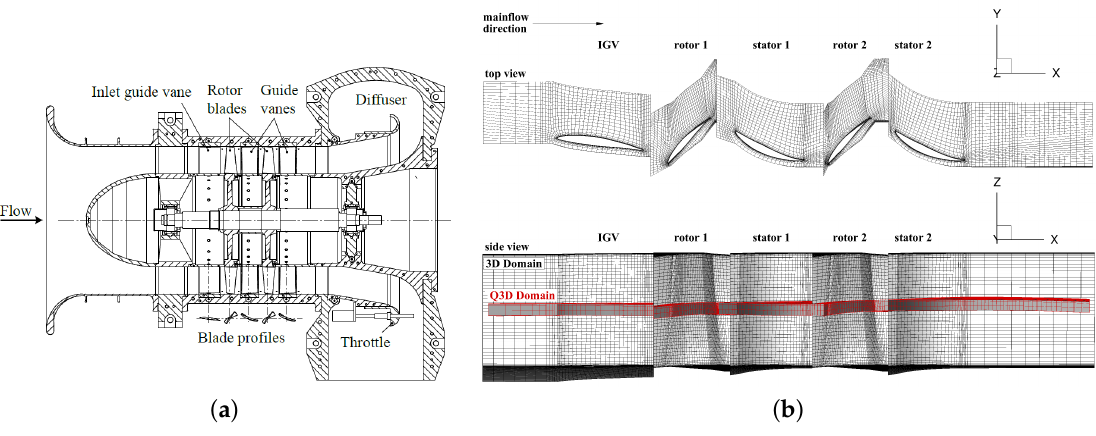
Figure 5. Schematic overview and computational domain of the Low-Speed Axial Compressor. ( a ) Schematic overview; ( b ) Computational domain. IGV: Inlet Guide Vane.